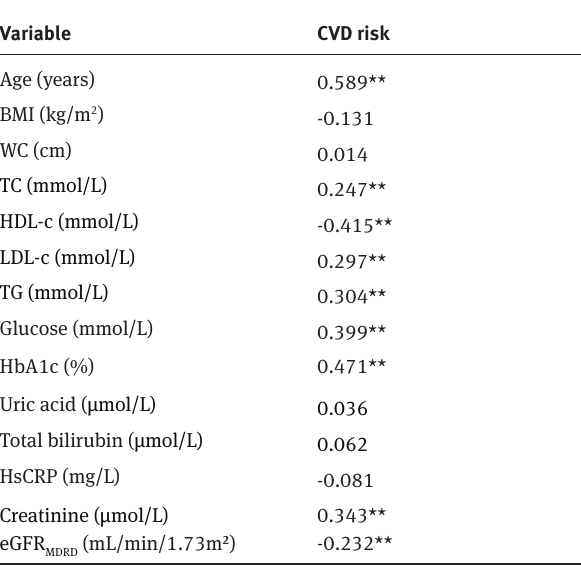
Table 3: Associations between CVD risk and clinical parameters using Spearman’s correlation